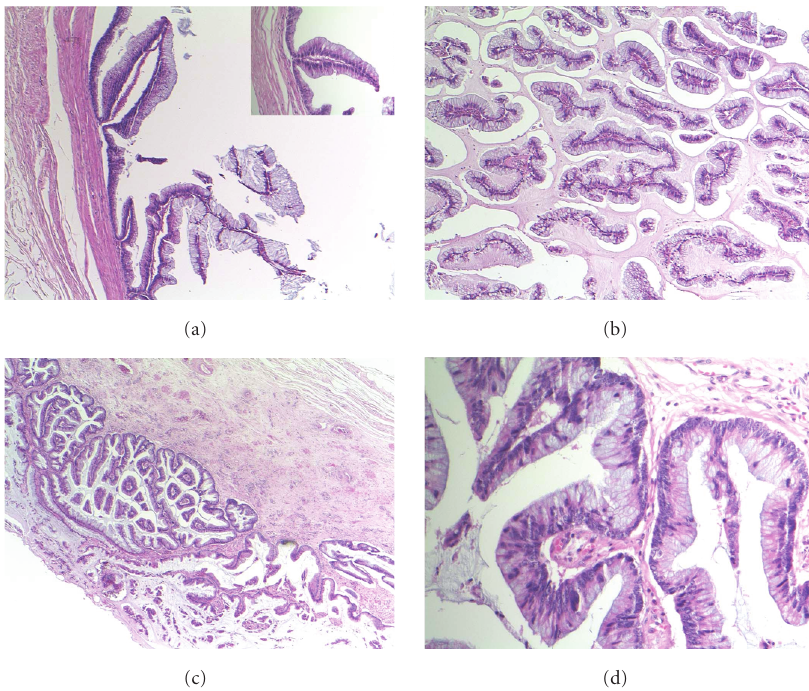
Figure 2: (a) Villous adenoma of the bladder with complex branching papillary structures, that are distended due to the presence of the exophytic mass in the lumen. There is no invasion into the underlying bladder wall ‘ (Hematoxylin Eosin stain, original magnification 50 × ) Inset: Higher magnification shows that the fibrovascular stalks of the adenoma are lined by pseudostratified mucinous epithelium with only mild degree of anisokaryosis. (Hematoxylin Eosin stain, original magnification 200 × ), (b) Urachal mucinous adenocarcinoma characterized by small sheets and nests of columnar mucinous cells floating in extracellular mucin. (Hematoxylin Eosin stain, original magnification 50 × ), (c) The cysts are lined with urachal mucinous adenocarcinoma with invasion in the bladder wall. (Hematoxylin Eosin stain, original magnification 25 × ), (d) Detail of papillary projections coated with columnar mucinous cells with pseudostratification, nuclear hyperchromasia and crowding, and goblet cells. (Hematoxylin Eosin stain, original magnification 200 ×